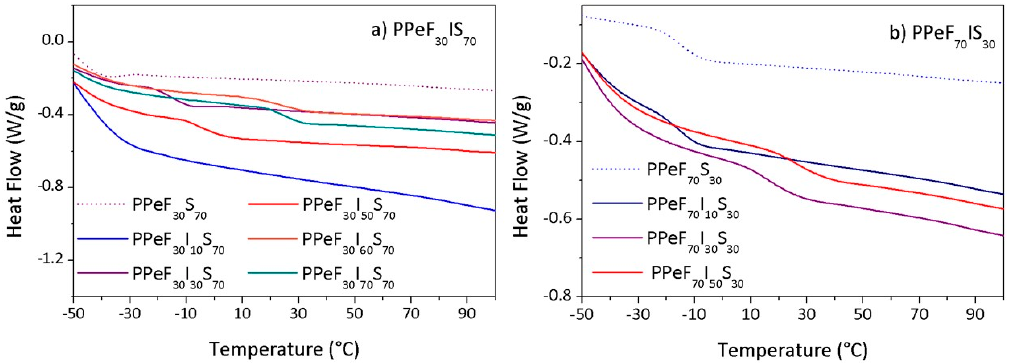
Figure 5. Second heating scan at 10 °C/min for polyesters ( a ) PPeF 30 IS 70 including PPeF 30 S 70 as the no-isosorbide reference and ( b ) PPeF 70 IS 30 including PPeF 70 S 30 as the no-isosorbide reference. Table 4. Thermal transitions of PPeFIS polyesters measured by differential scanning calorimetry (DSC). Polyester Mol% Isosorbide M w , Da T g , ◦